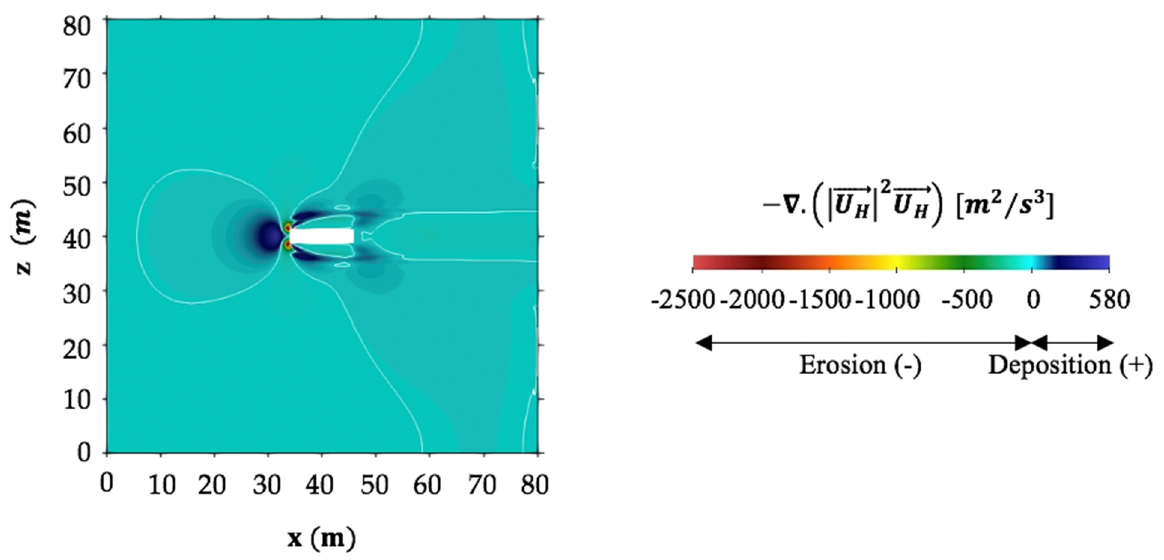
Figure 13. Numerical model predictions of the erosion and deposition patterns inferred from the convergence of the third-order horizontal wind velocity field at a horizontal near-surface plane, y = 0.25 m, around the full-scale building. The reference wind velocity magnitude is 17 m/s at a reference height of 1.8 m. The wind direction is from the left and perpendicular to the front face of building. The white lines are zero contours.